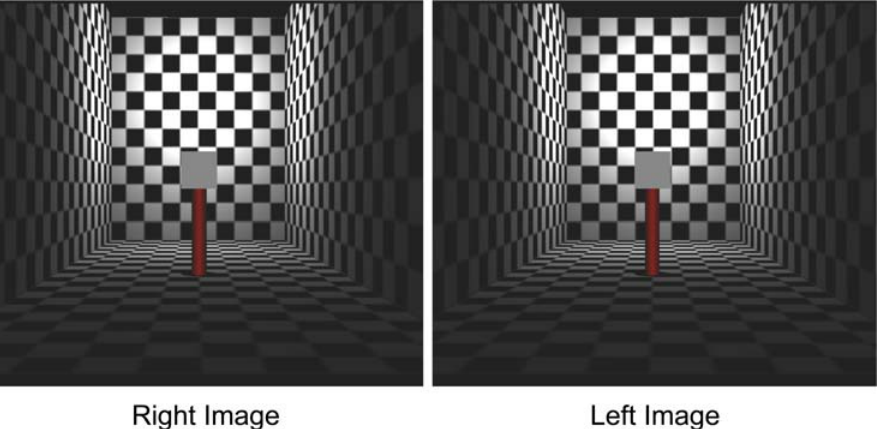
Figure 4. Stereo example of the scene. An example of the scene with pictorial cues and binocular disparity cues (for crossed fusion). The test patch is 6 meters from the back wall, 11.5 meters from the